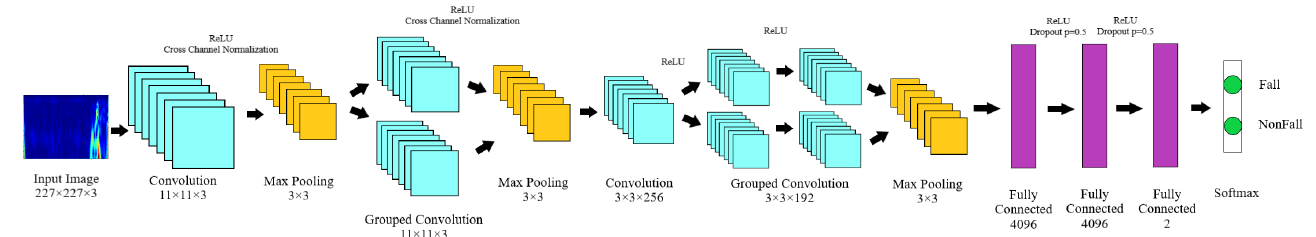
Figure 7. The CNN’s